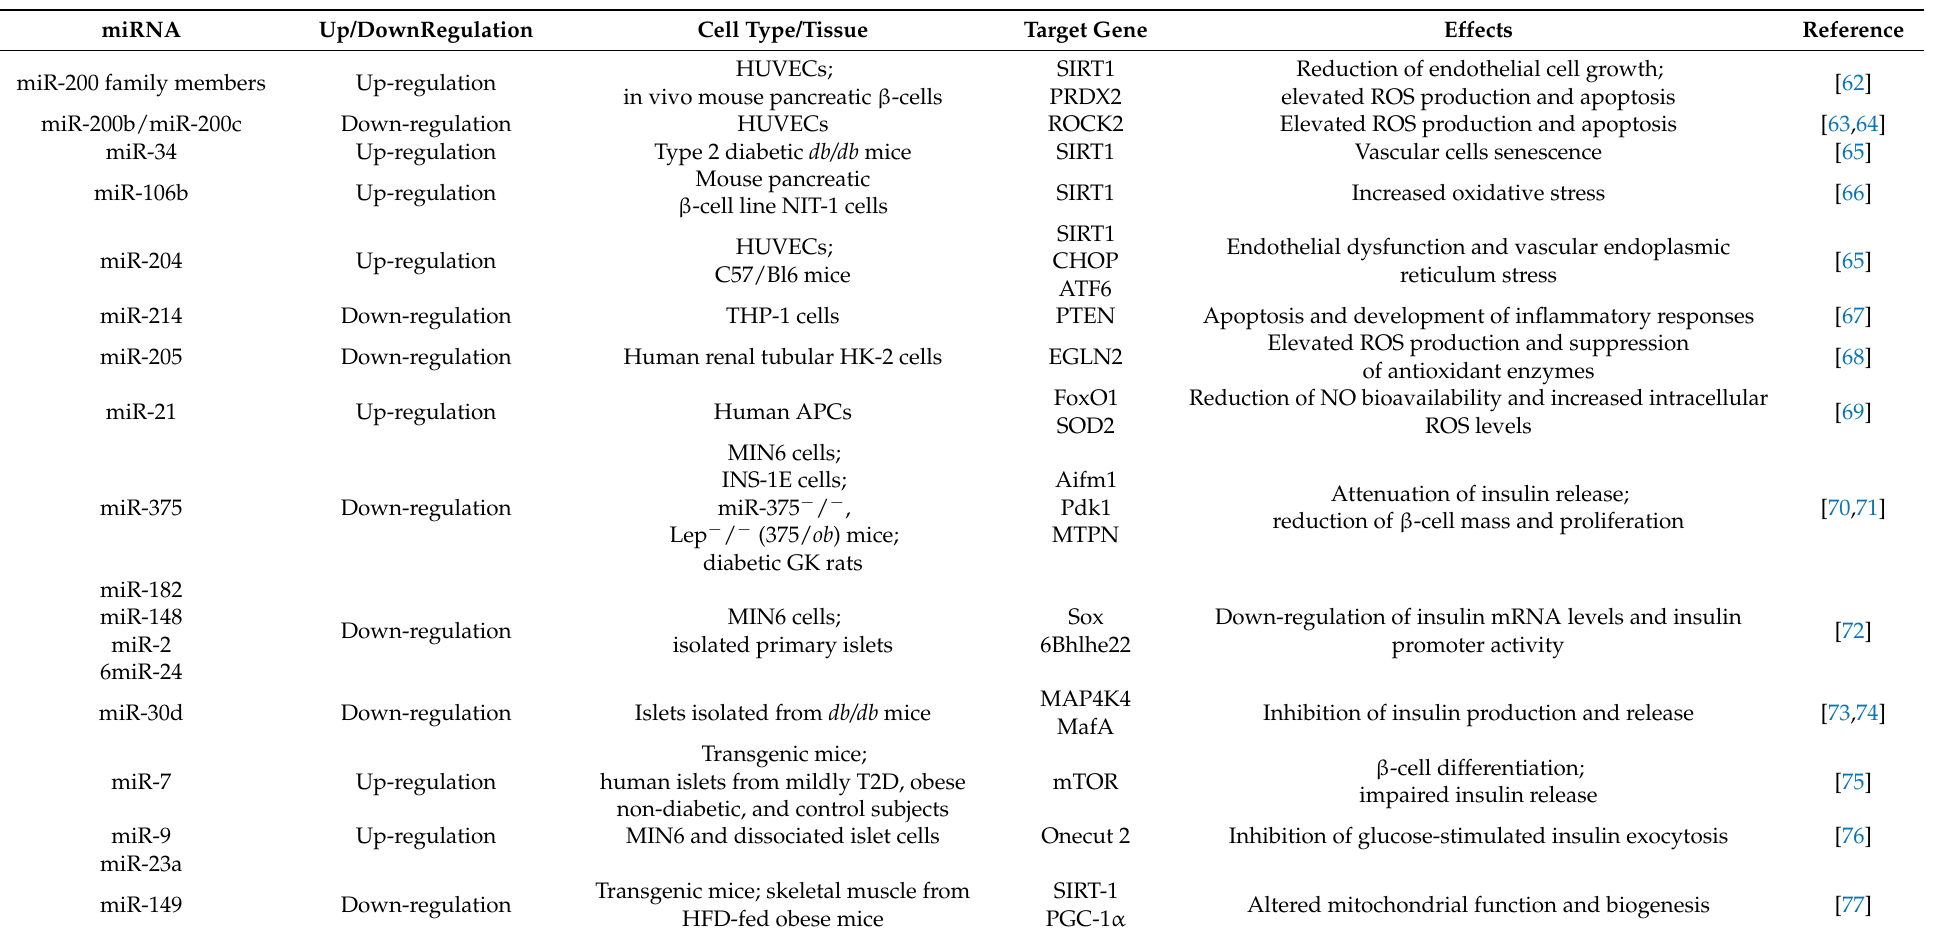
Table 1. MiRNAs implicated in type 2 diabetes and its oxidative stress-induced complications. Consequently, the restoration of miRNA expression to normal levels may represent an alternative therapeutic intervention to counteract oxidative